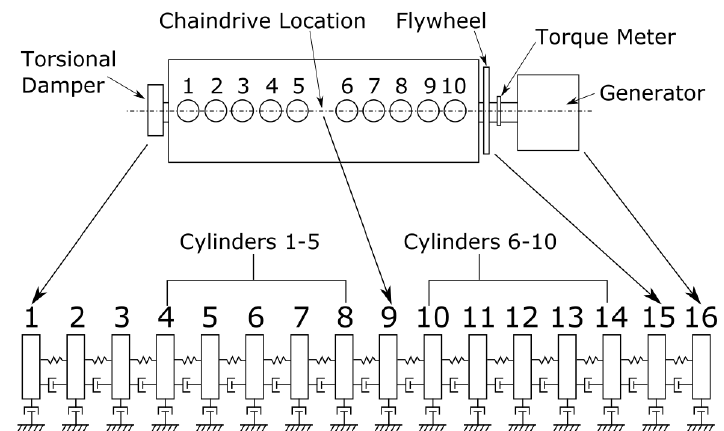
Figure 1. Reference system schematic and equivalent lumped mass